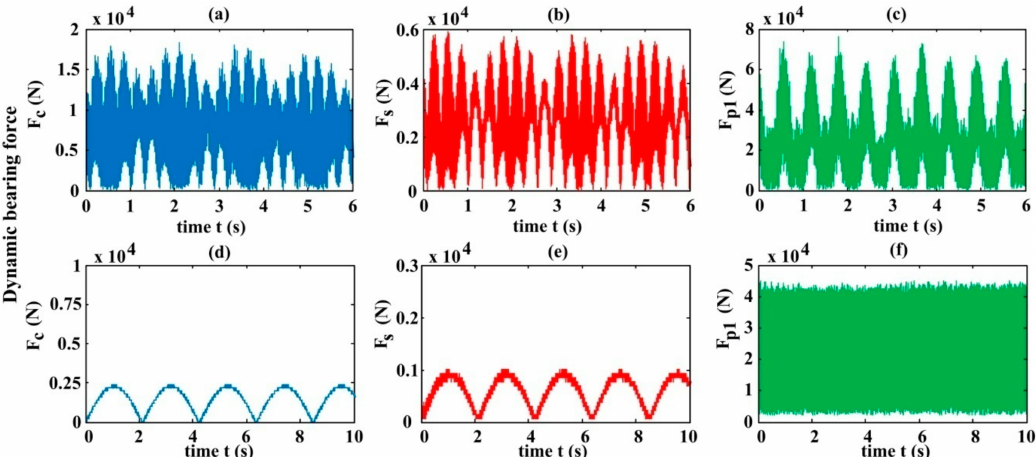
Figure 10. Variation of the dynamic bearing forces of main components (( a , d ) carrier, ( b , e ) sun, and ( c , f ) planet) with gear mesh time, which are represented as F c , F s , and F p1 , respectively. ( a – c ) the model with the planet–gear eccentric error excitation E p1 = 100 µ m; while ( d – f ) the model without error